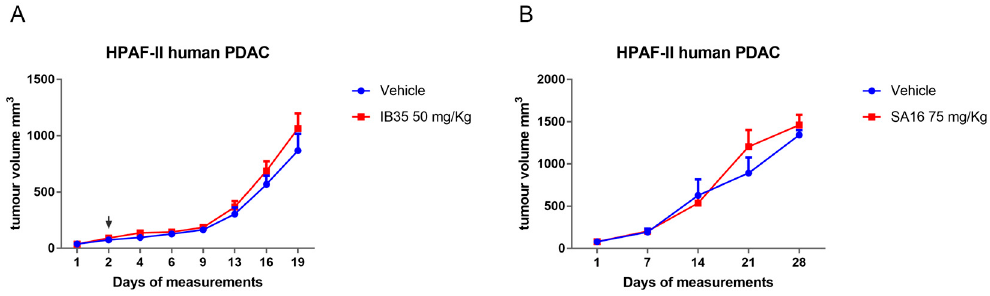
Figure 7. Graph showing tumor growth of HPAF-II xenograft mouse model treated with vehicle ( n = 8) and ( A ) 50 mg / kg IB35 ( n = 8) and ( B ) 75 mg / kg SA16 ( n = 8). Black arrow indicates start of the treatment